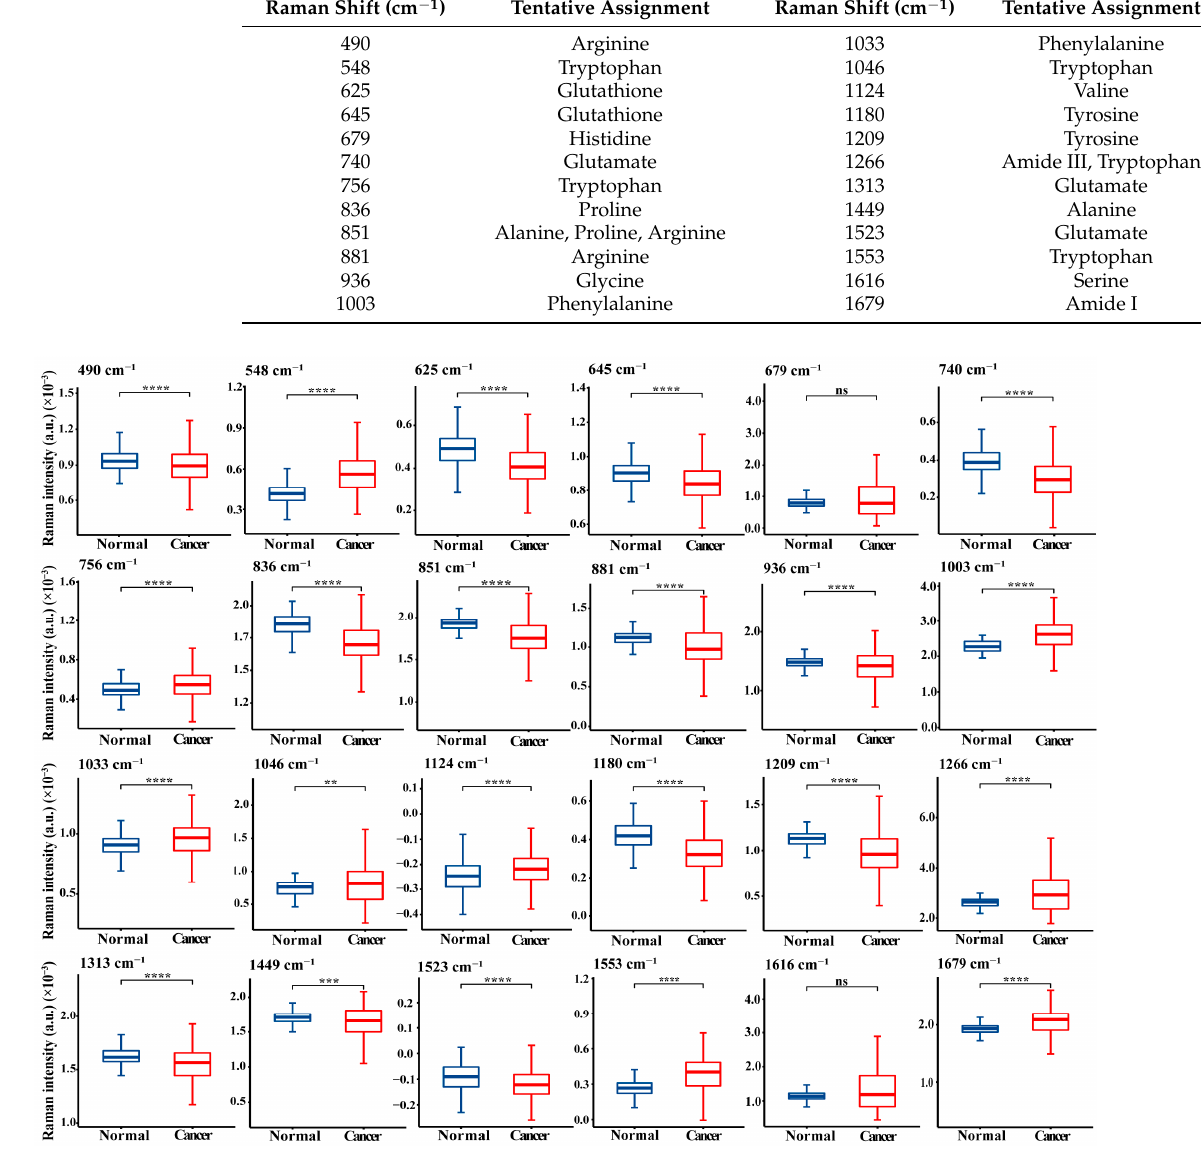
Figure 4. Box plots of the peak intensities of protein SERS spectra for the normal volunteers and NPC subjects at all stages. For each box, the central line represents the median, and the lower and upper boundaries indicate the 25th and 75th percentiles, respectively. Abbreviations: ns indicates no significance; ** p < 0.01; *** p < 0.001; **** p < 0.0001 (Mann–Whitney U